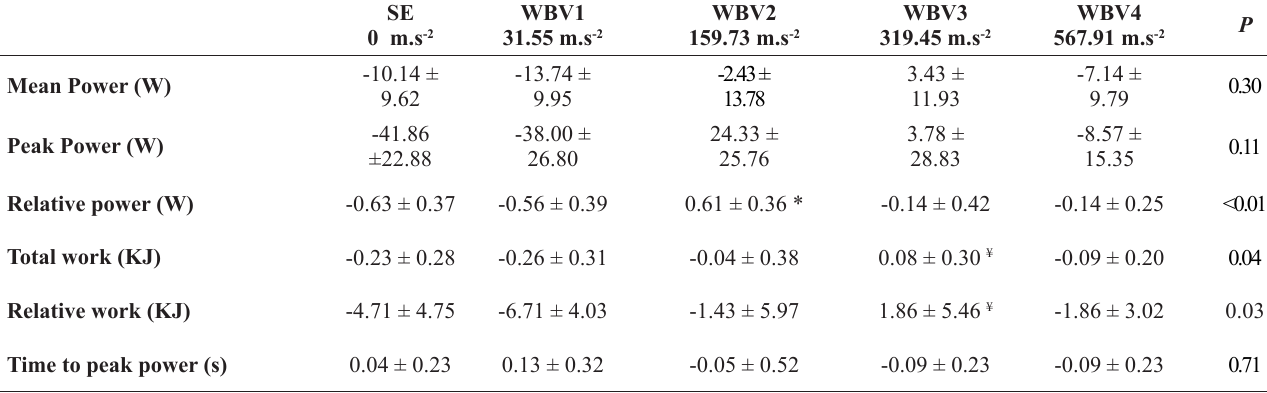
Table 2 - The change (Δ = Post – Pretest) in WT among the experimental conditions